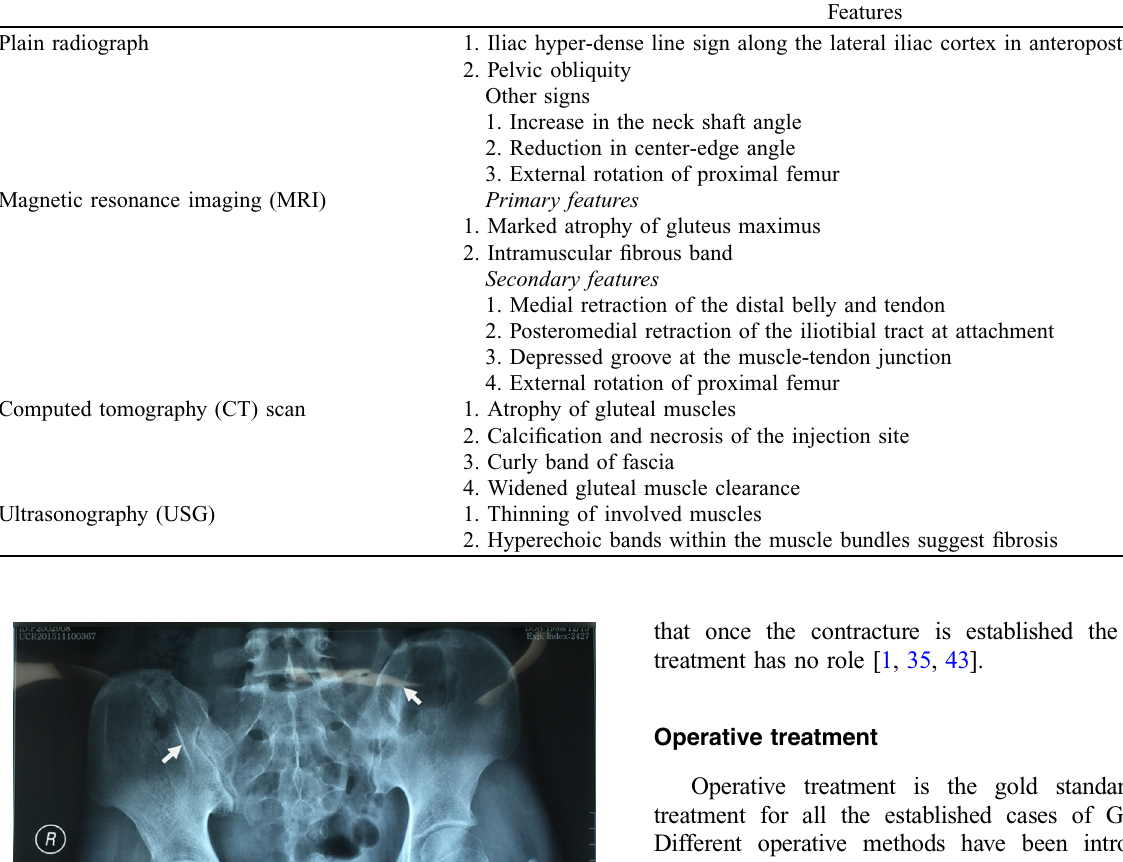
Table 2. Imaging modalities of gluteal muscle contracture.